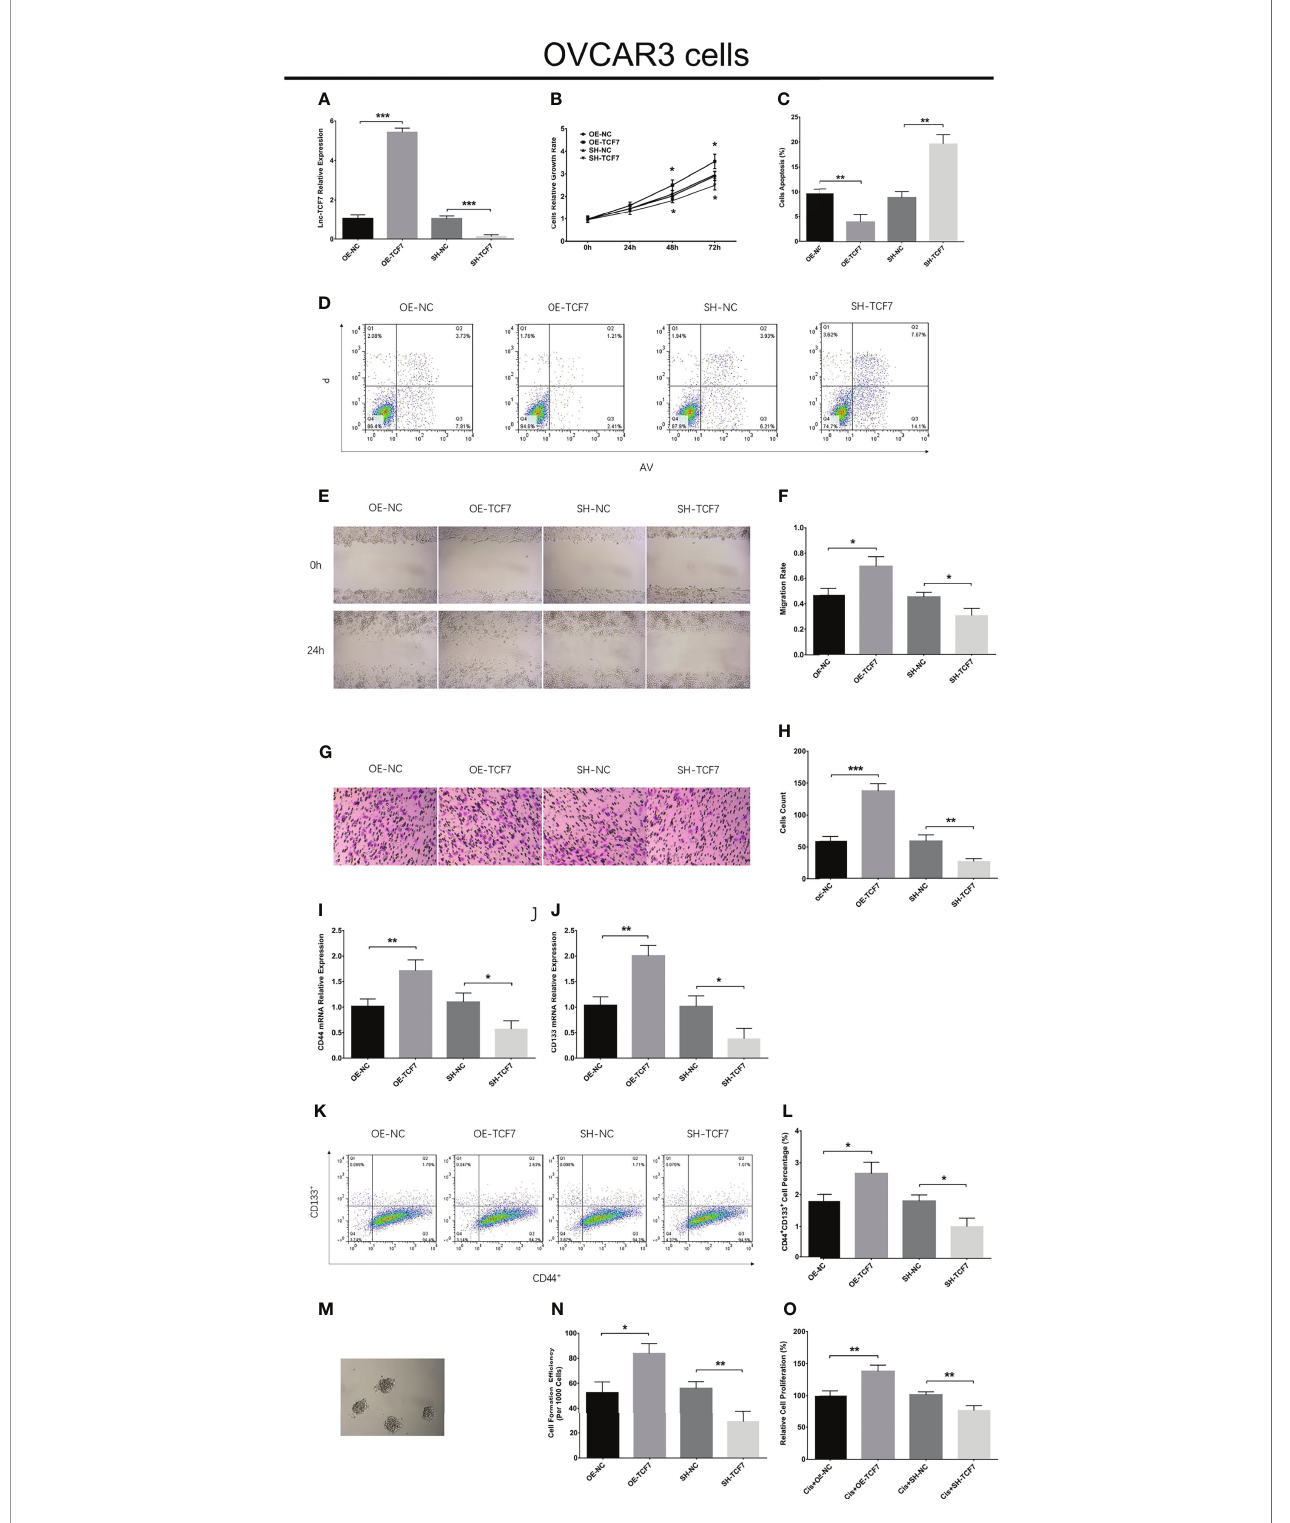
FIGURE 7 | Effect of lnc-TCF7 on cell proliferation, apoptosis, migration, invasion, stemness and cisplatin sensitivity in OVCAR3 cells. Lnc-TCF7 expression (A) , cell proliferation (B) , cell apoptosis rate (C, D) , cell migration (E, F) , cell invasion (G, H) , CD44 expression (I) , CD133 expression (J) CD44 + CD133 + cell percentage (K, L) , spheres formation ef fi ciency (M, N) and cisplatin sensitivity (O) after corresponding transfections. Experiments were performed in triplicates. * represented P < 0.05, ** represented P < 0.01, *** represented P < 0.001, ns represented no signi fi